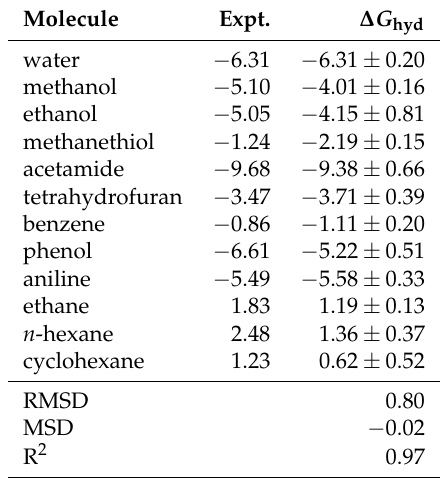
∆ G water Expt hyd = 0.6317. All results are ∆ G water HF hyd